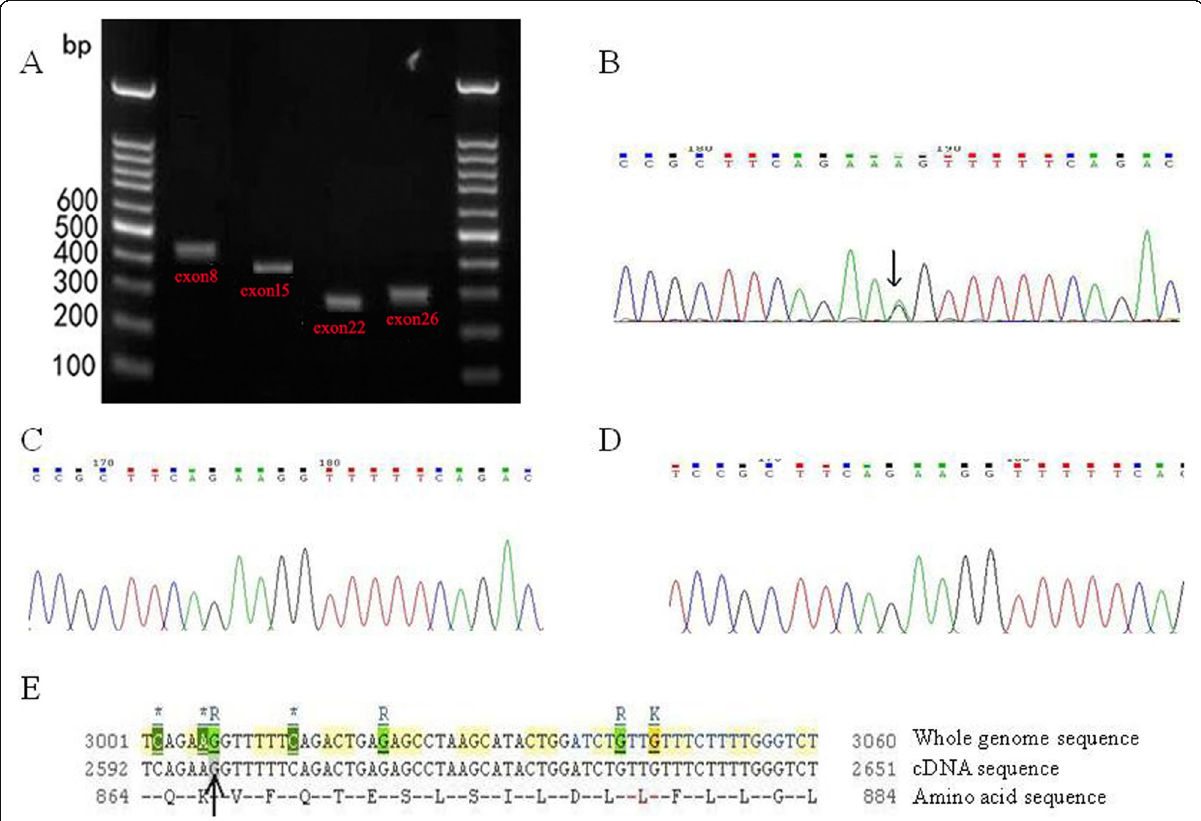
Fig. 3 Exon 26 sequencing for the ATP2C1 gene in pedigree I. a PCR amplification for exons 8, 15, 22 and 26 of ATP2C1 . b Sequencing result of exon 26 for the proband in pedigree I. c Sequencing result of exon 26 for normal member in the same pedigree. d Sequencing result of exon 26 for normal individual who was not blood related. e A synonymous mutation c.G2598A(Bases G → A) in exon 26 of ATP2C1 gene in the Ensemble database (indicated by